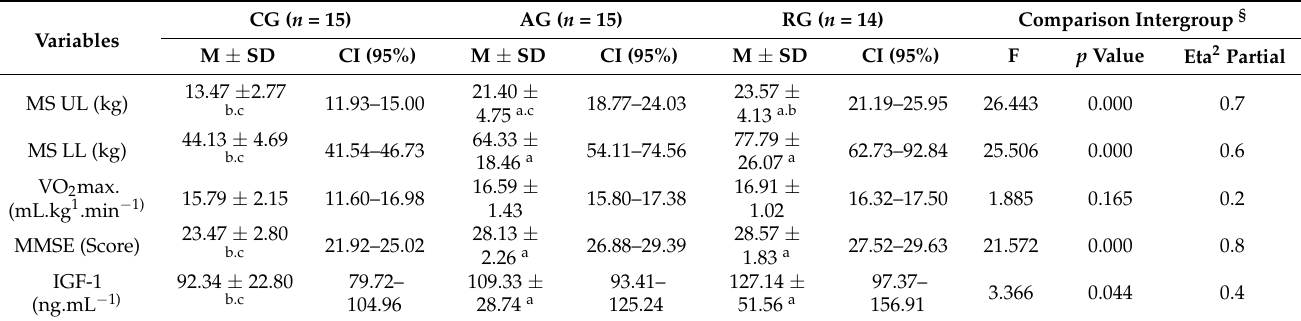
Table 4. Intergroup comparison of aerobic capacity (VO 2 max), maximum muscular strength (MS) of upper limbs (UL), lower limbs (LL), cognitive state (MMSE), and growth factor concentration (IGF-1). Post-test.